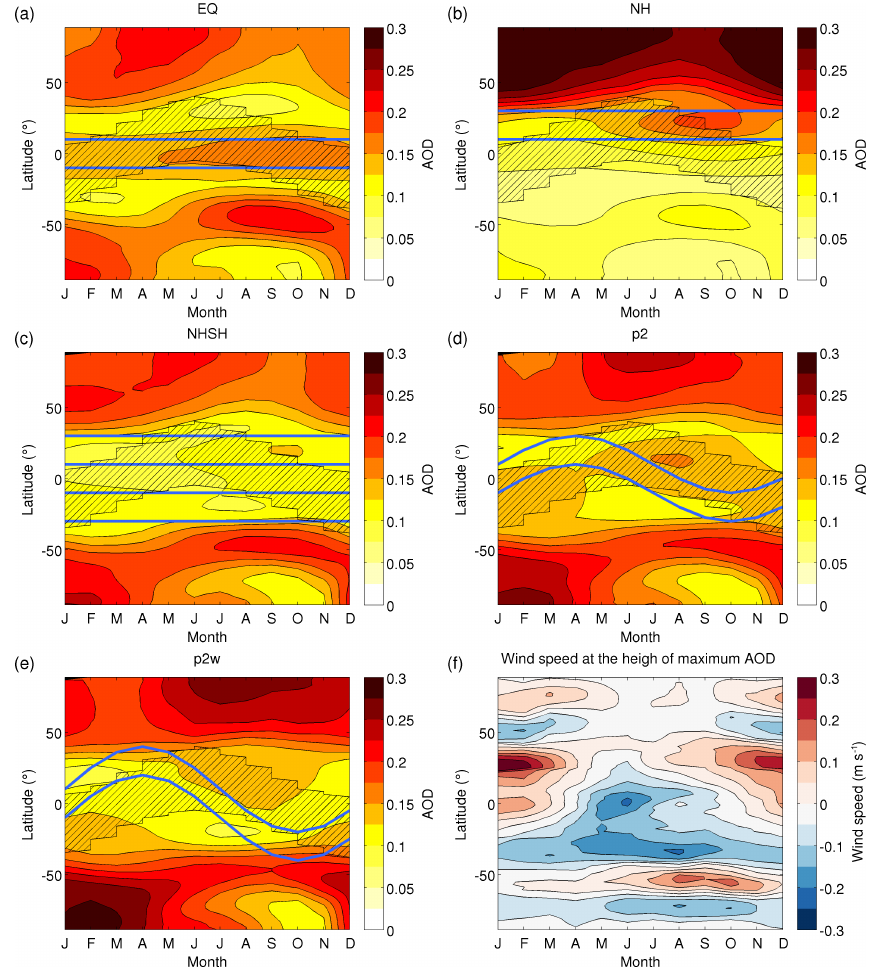
Figure 6. The zonal mean stratospheric AOD at 533nm wavelength in (a) EQ, (b) NH, (c) NHSH, (d) p2, (e) p2w scenarios and the meridional wind component at the height of maximum AOD (positive values from south to north). The blue lines shows the boundaries of the injection area (two areas at c ) NHSH) and the hatching shows latitudes which receive over 50% of monthly solar